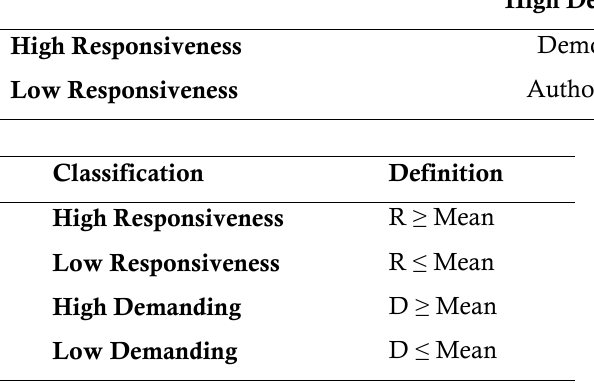
Table 3. Analysis of the relationship parental eating patterns and nutritional status of toddlers